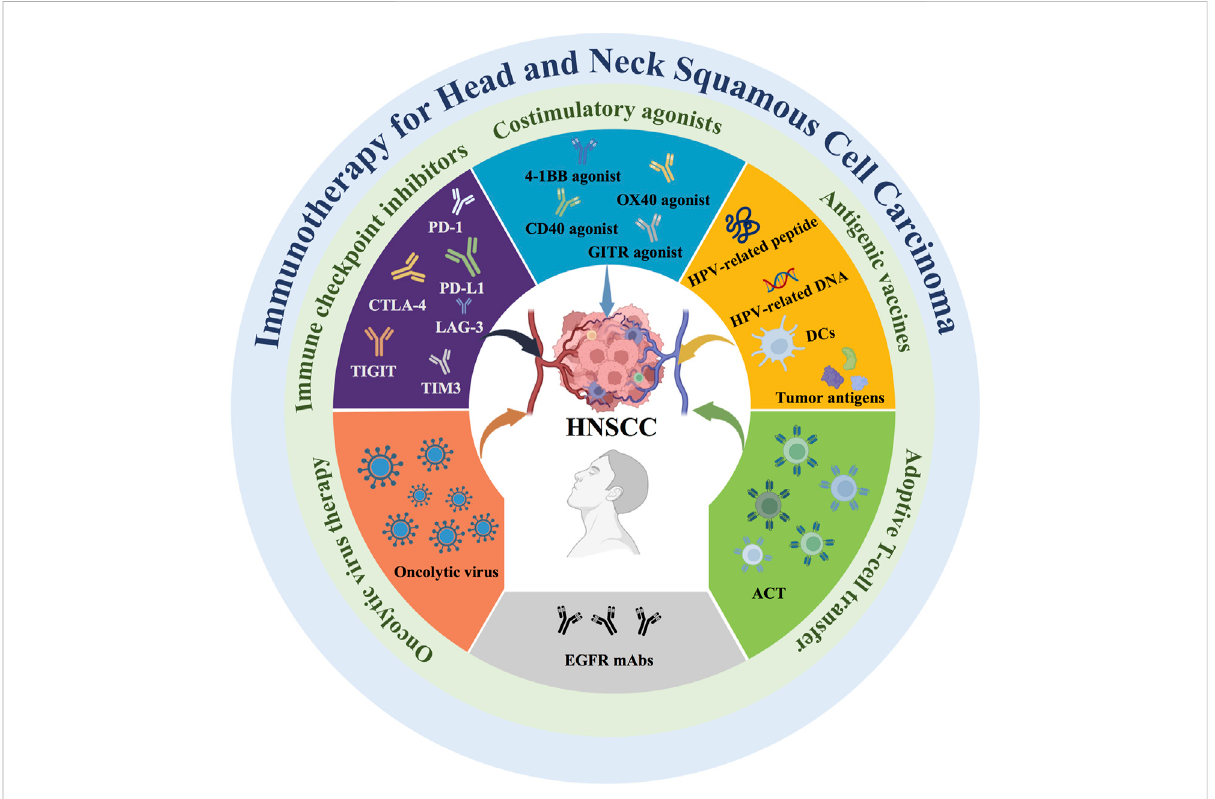
Current immunotherapy strategies for HNSCC. Current immunotherapies for HNSCC include immune checkpoint inhibitors, costimulatory agonists, antigenic vaccines, oncolytic virus therapy, adoptive T cell transfer (ACT), and epidermal growth factor receptor (EGFR)-targeted monoclonal antibodies